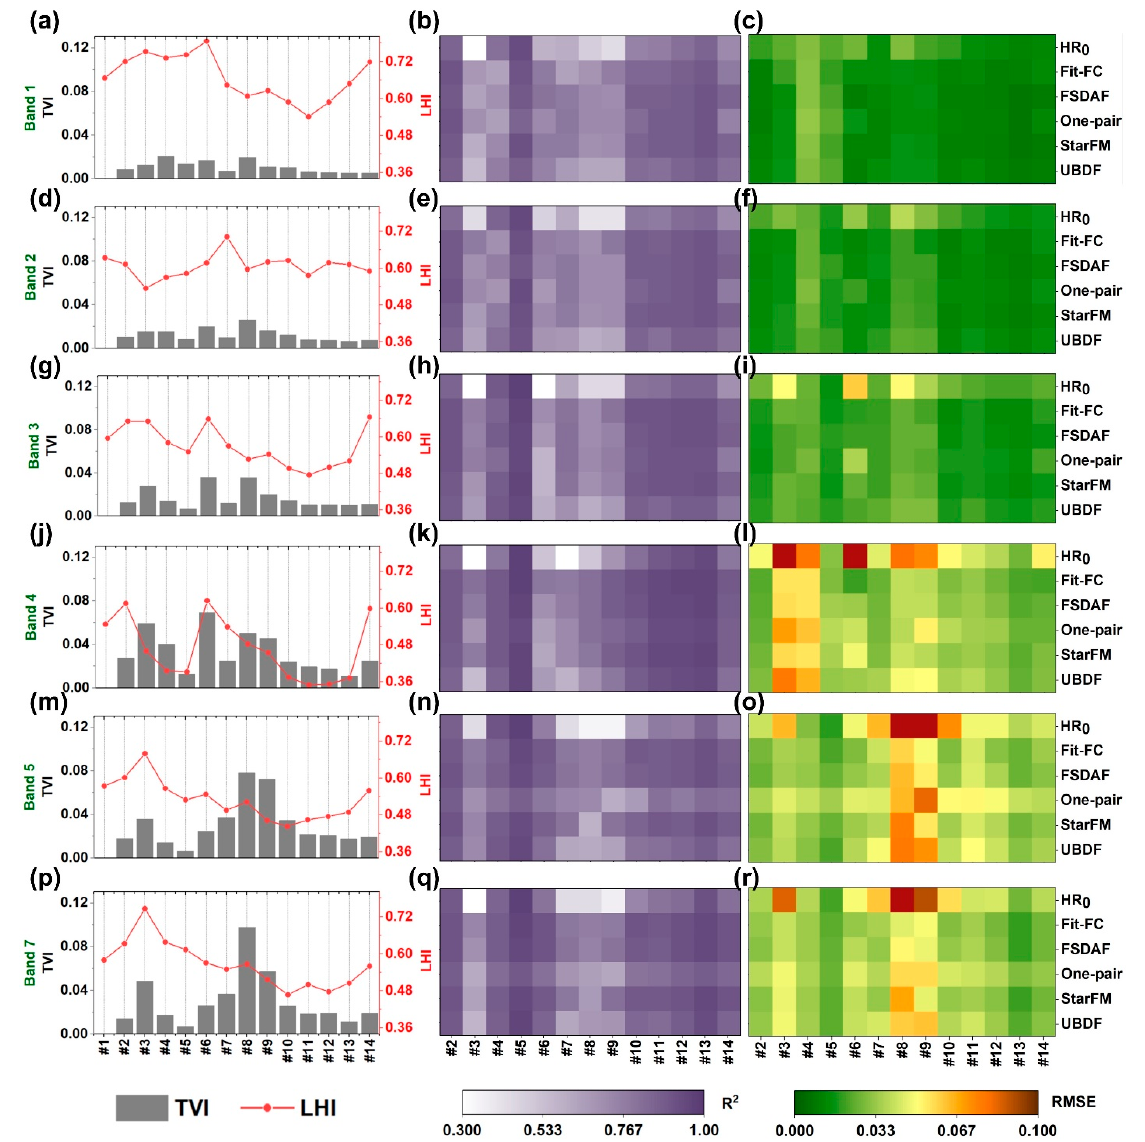
Figure 8. Time series plot of TVI and LHI ( a , d , g , j , m , p ) and metrics of R 2 ( b , e , h , k , n , q ) and RMSE ( c , f , i , l , o , r ) of each method for band 1, 2, 3, 4, 5, 7 (from top row to bottom row) for the whole Gwydir site. “HR 0 ” denotes R 2 and RMSE between target image and the prior image. The abscissa of all statistical charts is the image number in chronological order.